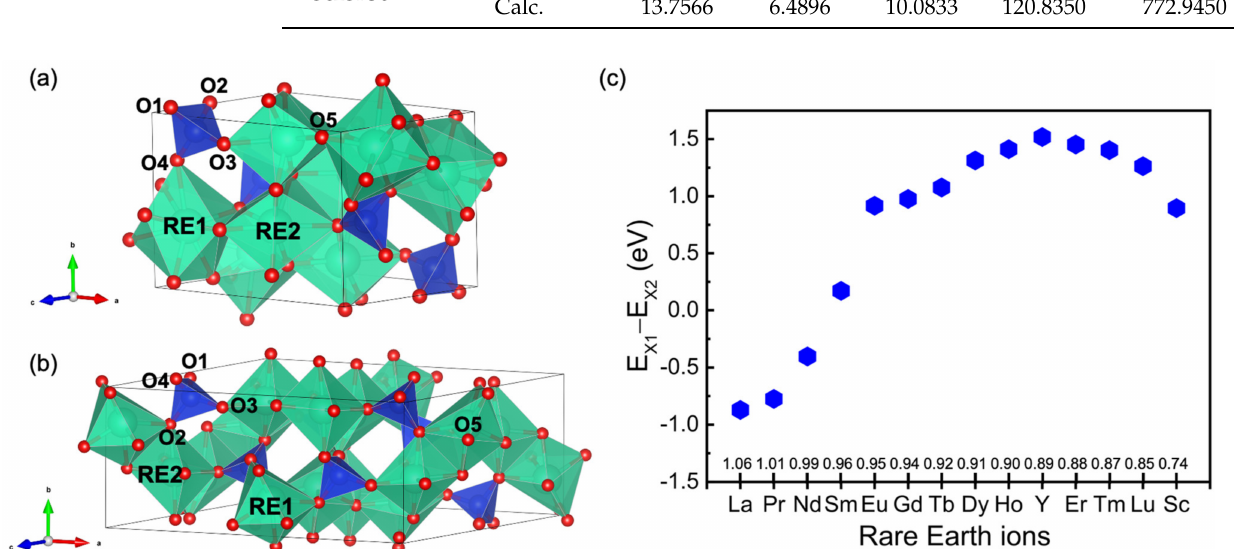
Figure 1. The crystal structure of RE 2 SiO 5 : ( a ) X1-RE 2 SiO 5 and ( b ) X2-RE 2 SiO 5 . Si tetrahedra, RE polyhedra and O atoms are colored by blue, green and red, respectively. ( c ) The energy difference between the X1 phase and X2 phase for the same RE 2 SiO 5